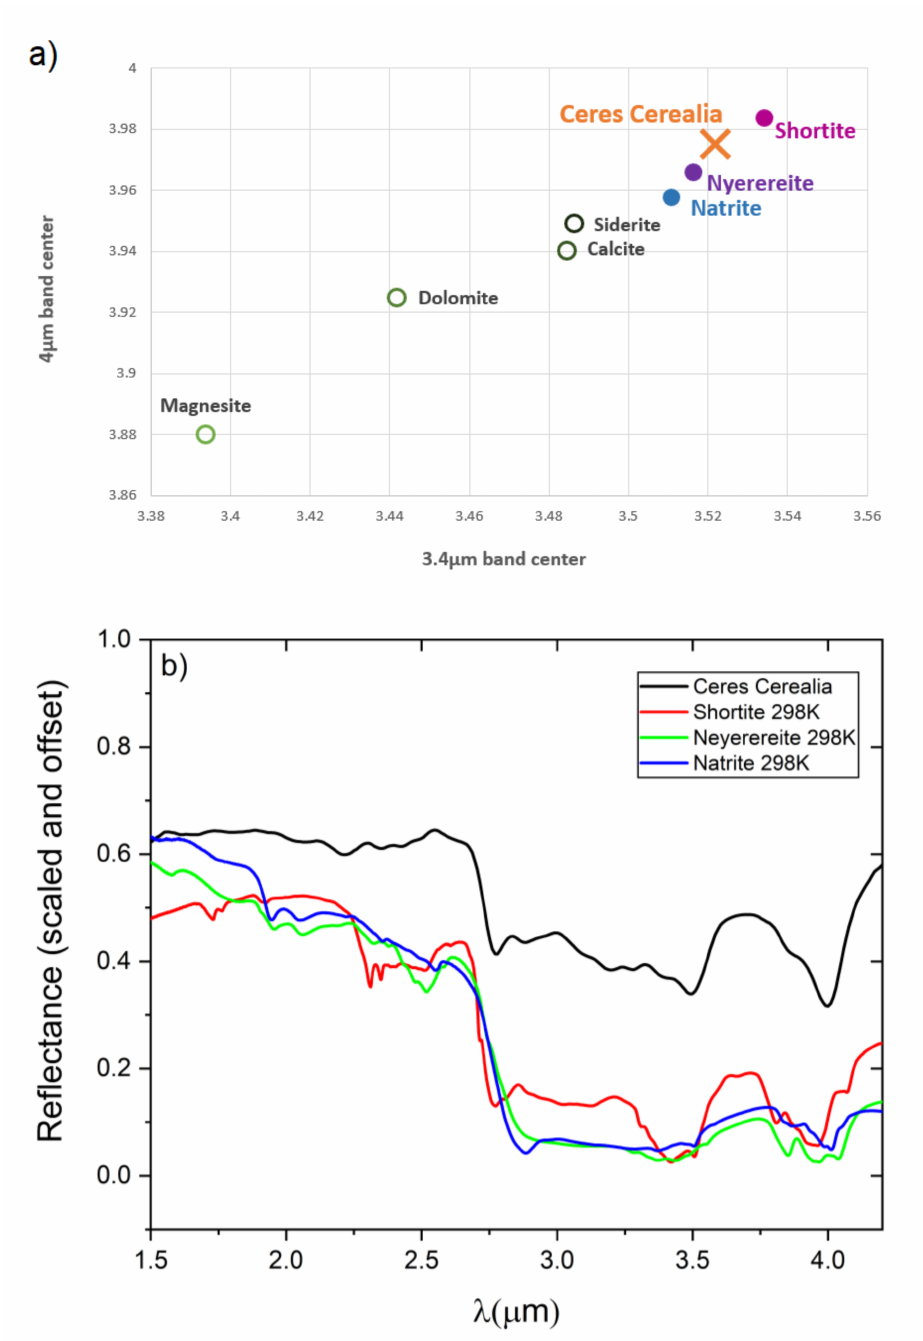
Figure 14. ( a ) Scatter plot of the absorption band centers for different carbonates shows that data from Ceres Cerealia bright areas are similar to those of natrite, nyerereite, and shortite, and they are quite different from other carbonates. ( b ) Laboratory spectra of natrite, shortite, and nyerereite at 298 K compared to spectrum of Ceres